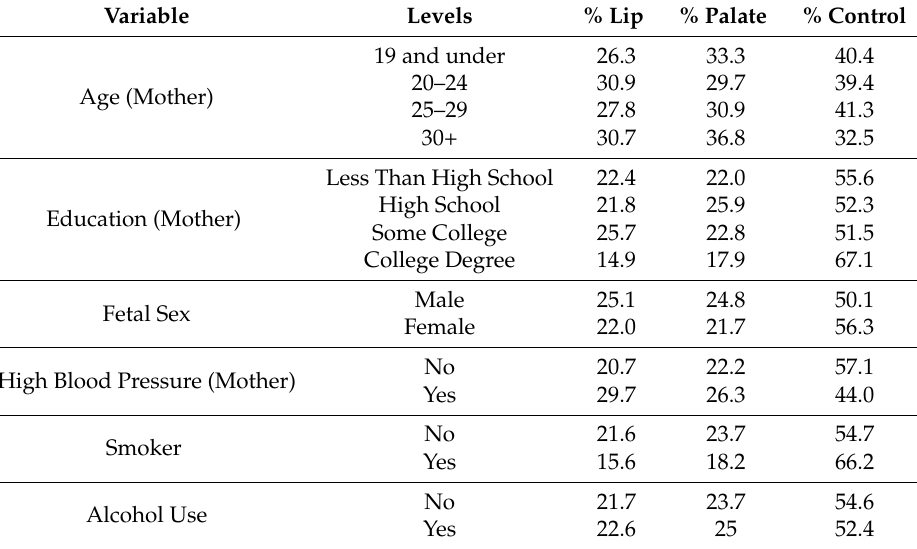
Table 1. Cleft defect variables tabulated by maternal and fetal characteristics, cleft lip includes both cleft lip and cleft lip and palate defects; similarly, cleft palate includes both cleft palate and cleft lip and cleft palate